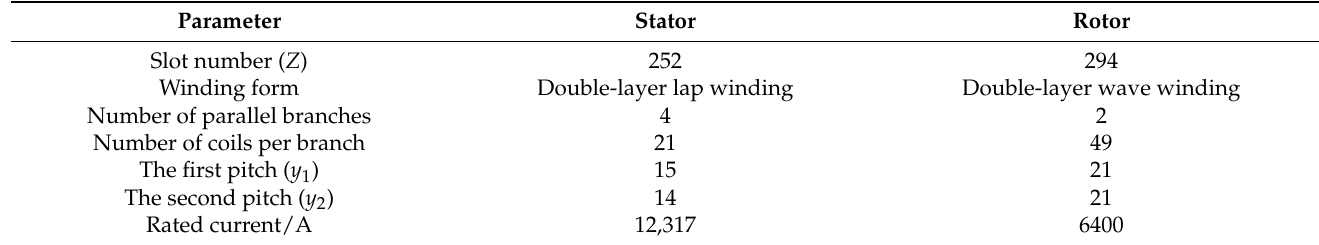
Table 1. The basic parameters of the VSPSGM.